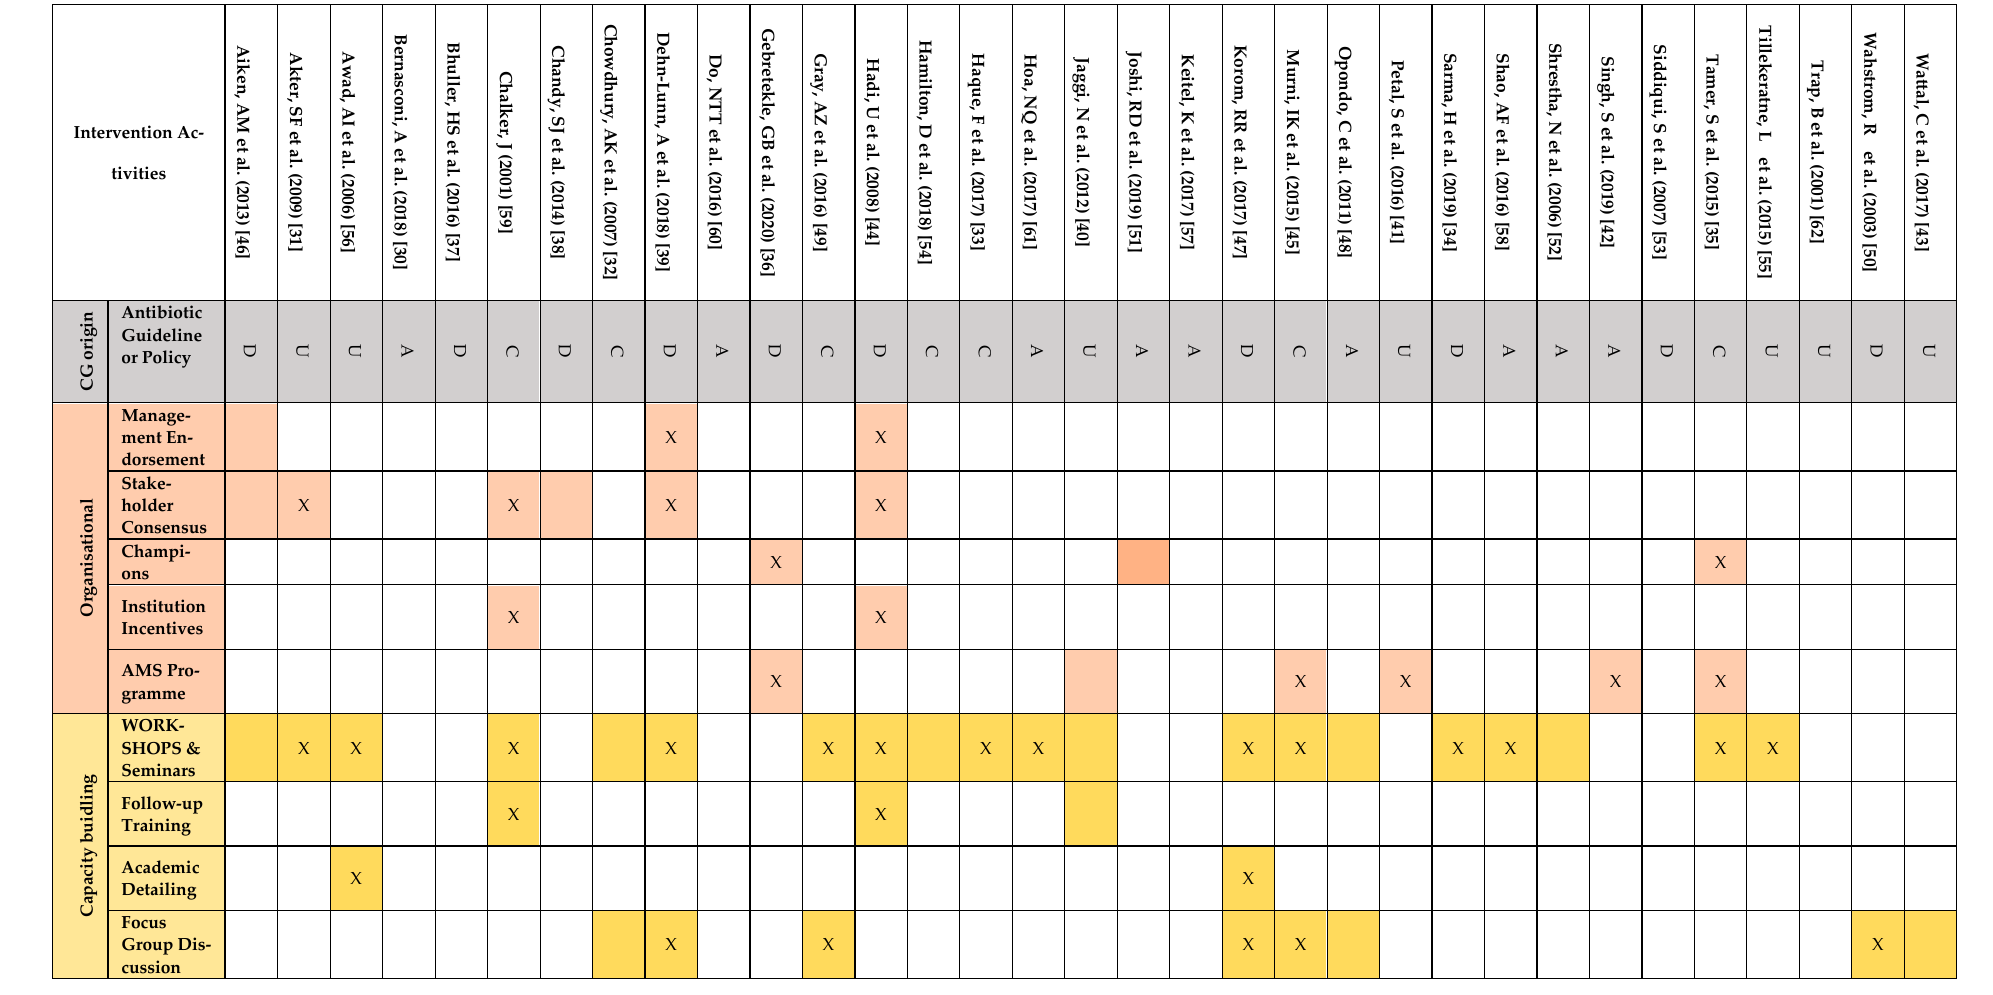
Table 2. Interventions used in the studies for implementing and promoting adherence to antibiotic guidelines in LLMICs.